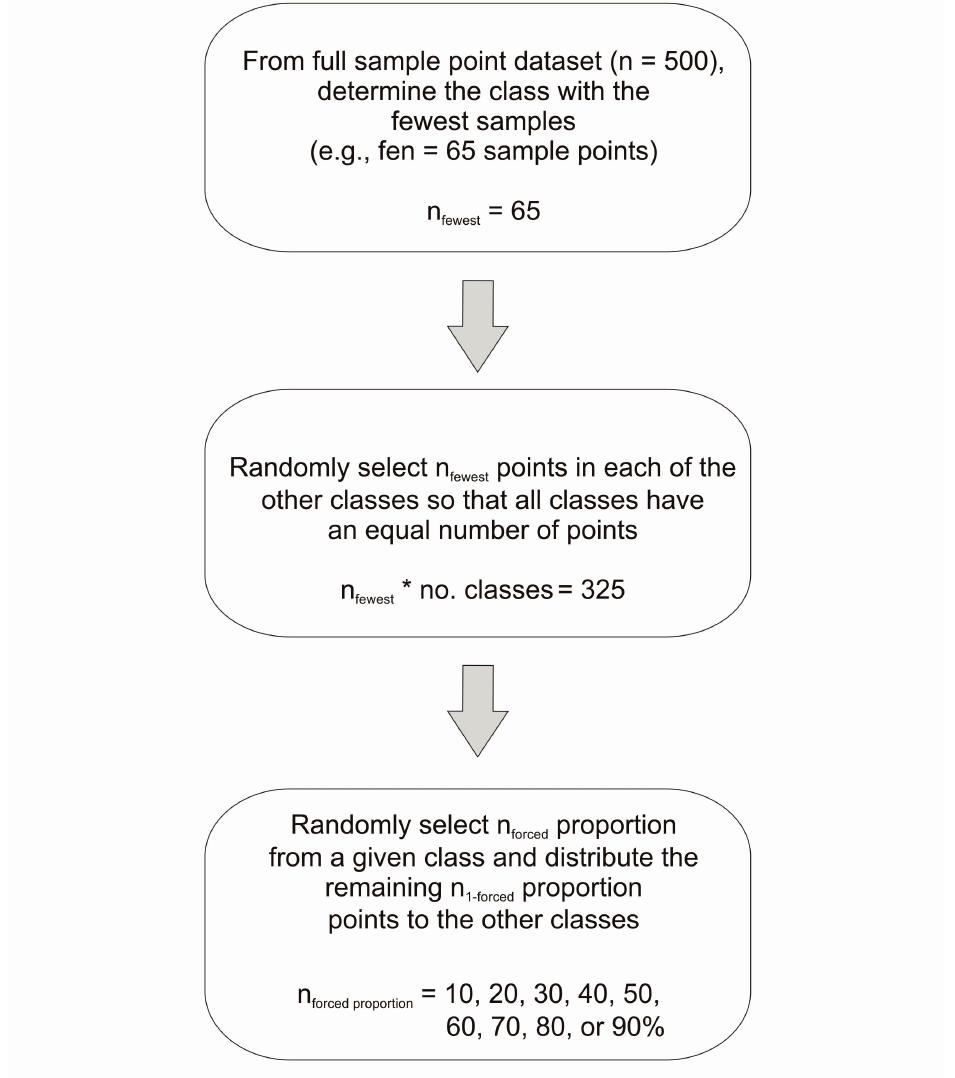
Figure 3. Flow chart describing the methods used to create each sample of data with ‘forced proportions’ in each